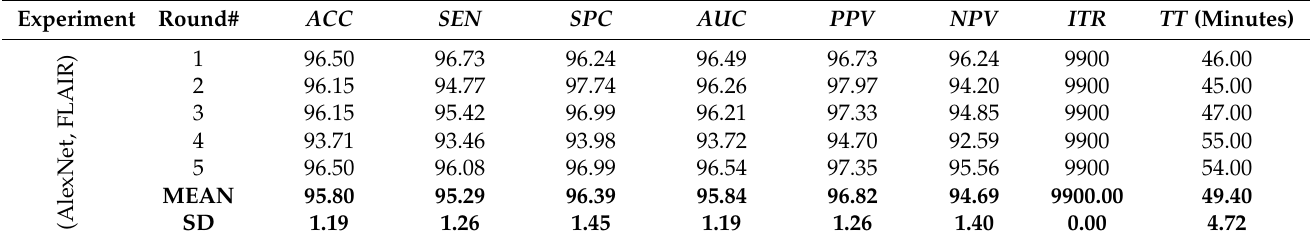
Table A15. Test results of five-folds of the experiment (AlexNet, FLAIR).